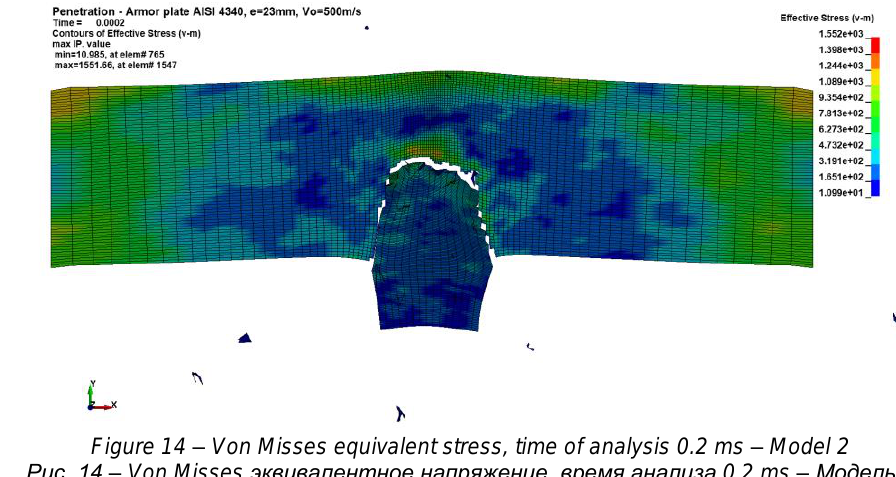
Figure 14 – Von Misses equivalent stress, time of analysis 0.2 ms – Model 2 Рис. 14 – Von Misses эквивалентное напряжение, время анализа 0.2 ms – Модель 2 Слика 14 – Von Misses-ов еквивалентни напон, време анализе 0,2 ms – модел